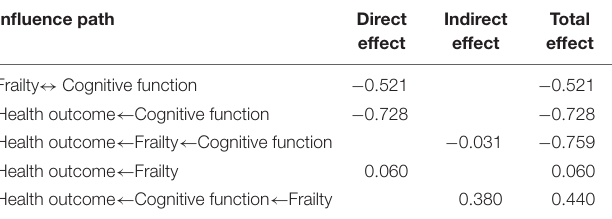
TABLE 5 | Pattern effect results of cognitive function, frailty, and health